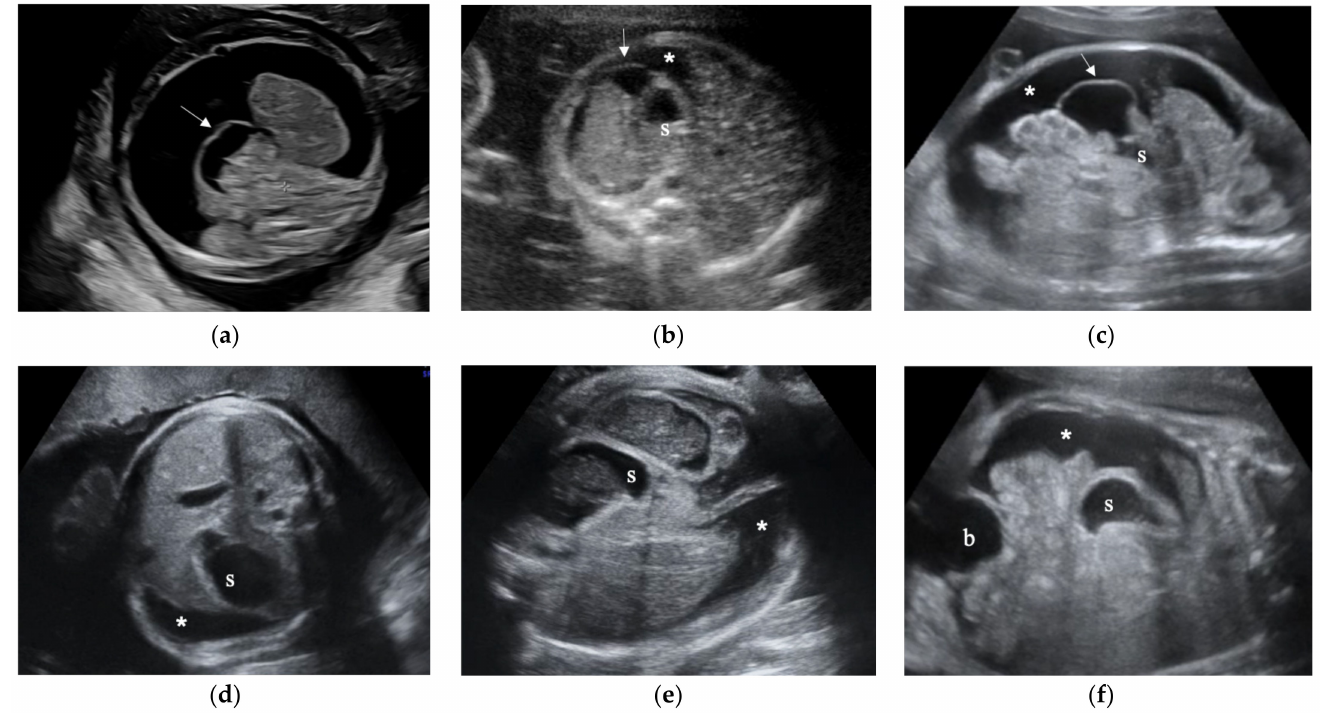
Figure 1. Ultrasound images of fetal ascites. ( a ) case 4, 22 weeks of gestation, ( b ) case 6, 26 weeks of gestation, ( c ) case 7, 28 weeks of gestation, ( d ) case 9, 31 weeks of gestation, ( e ) case 10, 39 weeks of gestation. ( f ) case 11, 28 weeks of gestation. Asterisk (*): ascites, arrow: greater omentum, s: stomach, b: